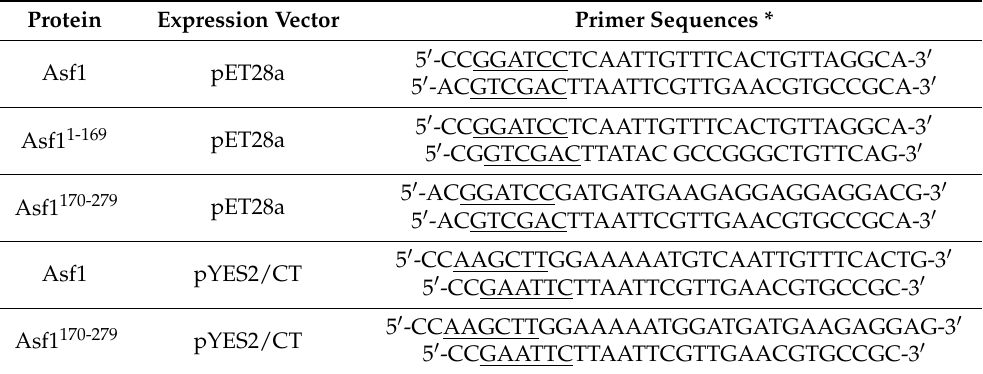
Table 2. Primer pairs used in this